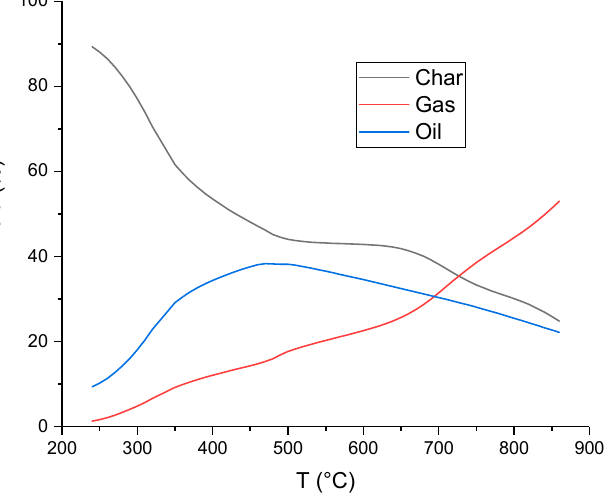
Figure 3. Effect of temperature on the yield of pyrolysis products (data adapted from ref. [77], slow pyrolysis, feedstock: spent mushroom substrate).